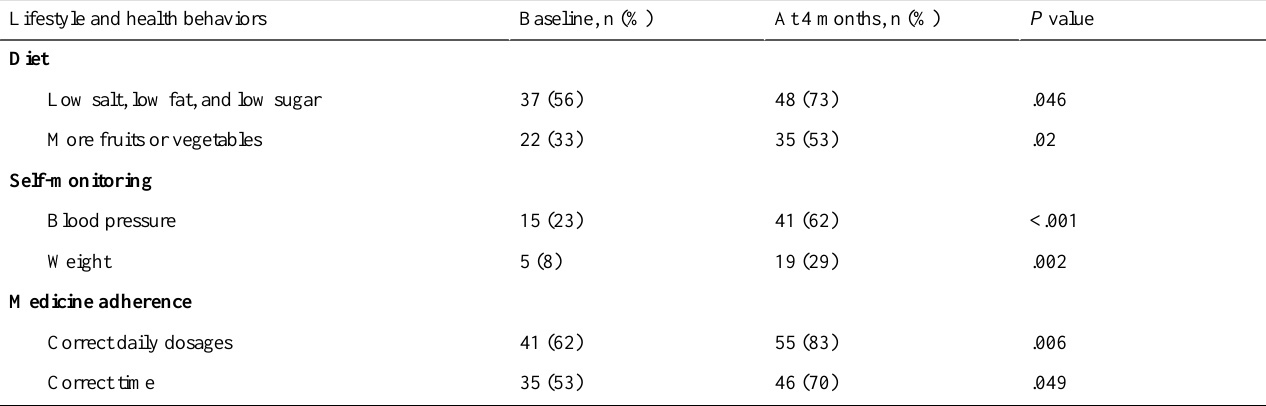
Table 3. Changes in lifestyle and health